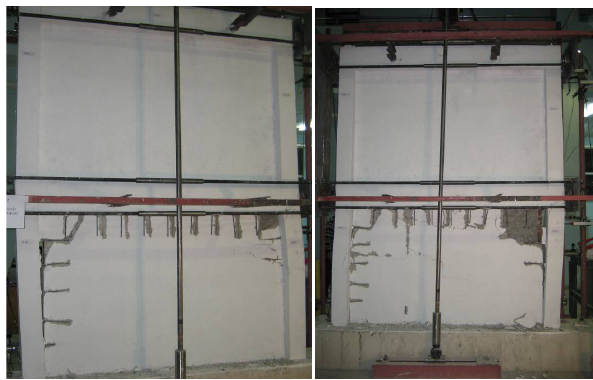
Figure 9 Load-top displacement hysteresis curve of SPS1 Fig. 9. Load-top displacement hysteresis curve of SPS1.